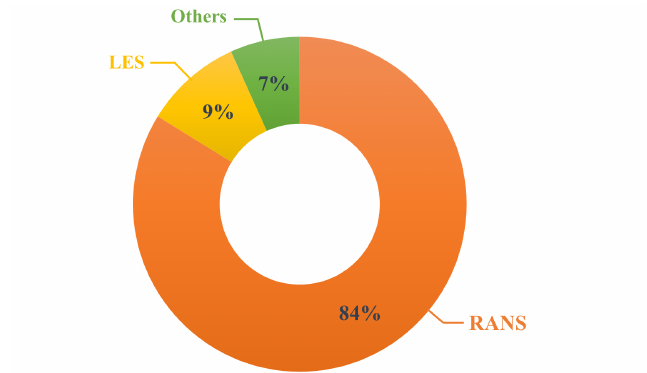
Figure 15. Types of simulations used in the examined